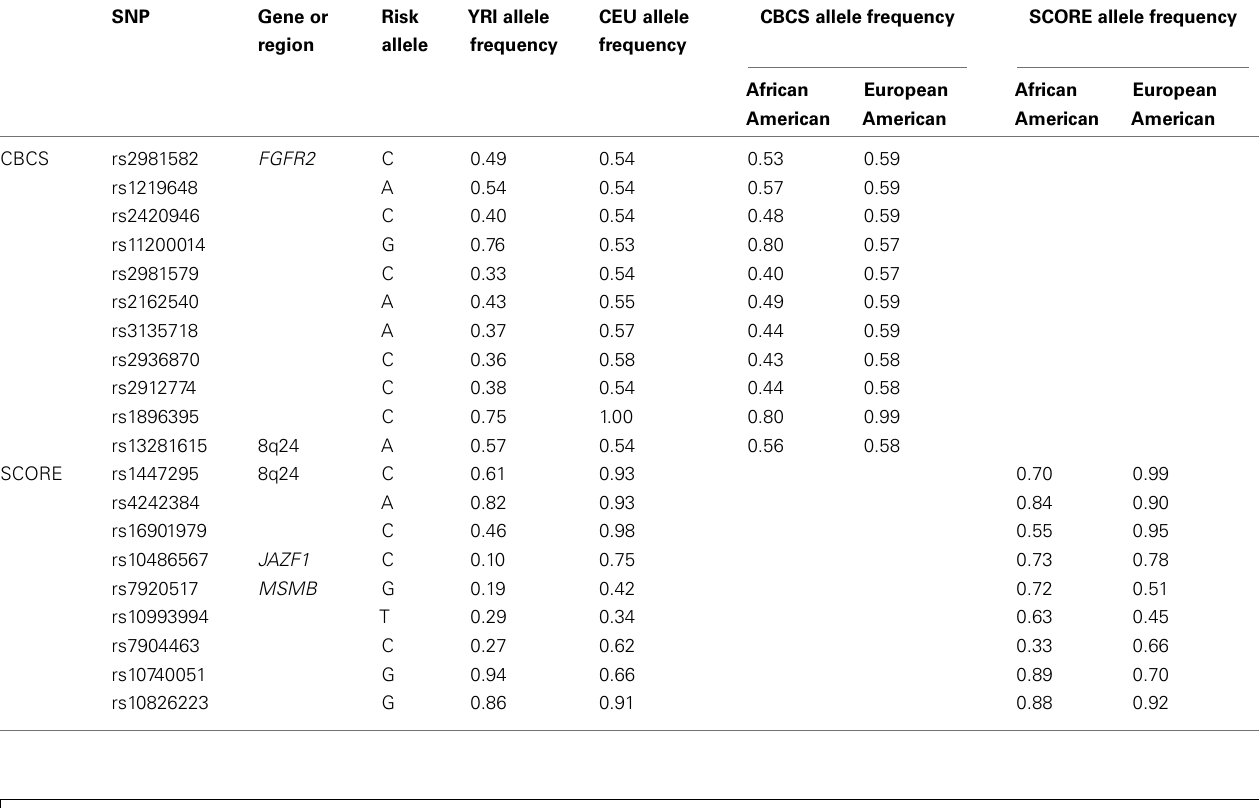
Table 1 | Carolina Breast Cancer Study and SCORE GWAS “hit” allele frequencies as compared to HapMap CEPH Europeans (CEU) andAfrican Yorubans (YRI).